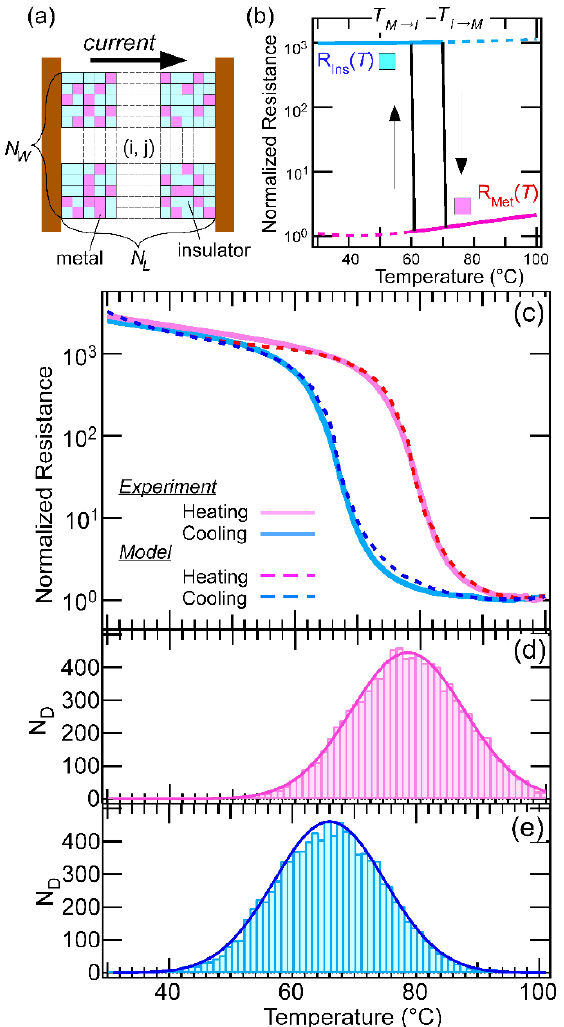
Figure 5. ( a ) Schematic of the phase-separated VO 2 with ( N L × N W ) domain geometry: metal (pink) and insulator (cyan) phases coexist between the electrodes. ( b ) Ideal R - T curves through the IMT and MIT for a single domain with T I → M of 70 ◦ C and T M → I of 60 ◦ C, respectively. ( c ) Comparison between the observed R - T curve for the VO 2 sample (solid lines) and the simulated one using Equation (1) (dashed line). Estimated N D values in ( d ) IMT and ( e ) MIT processes with T I → M = 77 ◦ C and T M → I = 65 ◦ C, respectively.